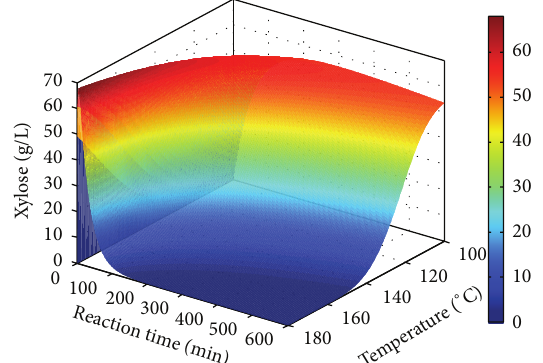
Table 1. The rate constants ( 𝑘 1𝑓 , 𝑘 1𝑠 , and 𝑘 2 ) in the